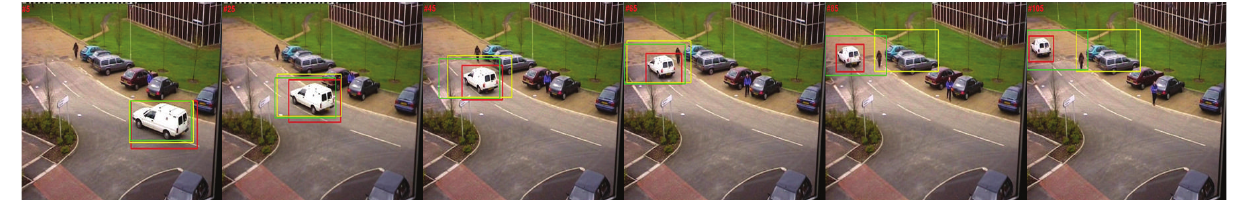
Figure 4: Tracking results of PETS2000 sequence of white car . Frames 5, 25, 45, 65, 85, and 105 are displayed.